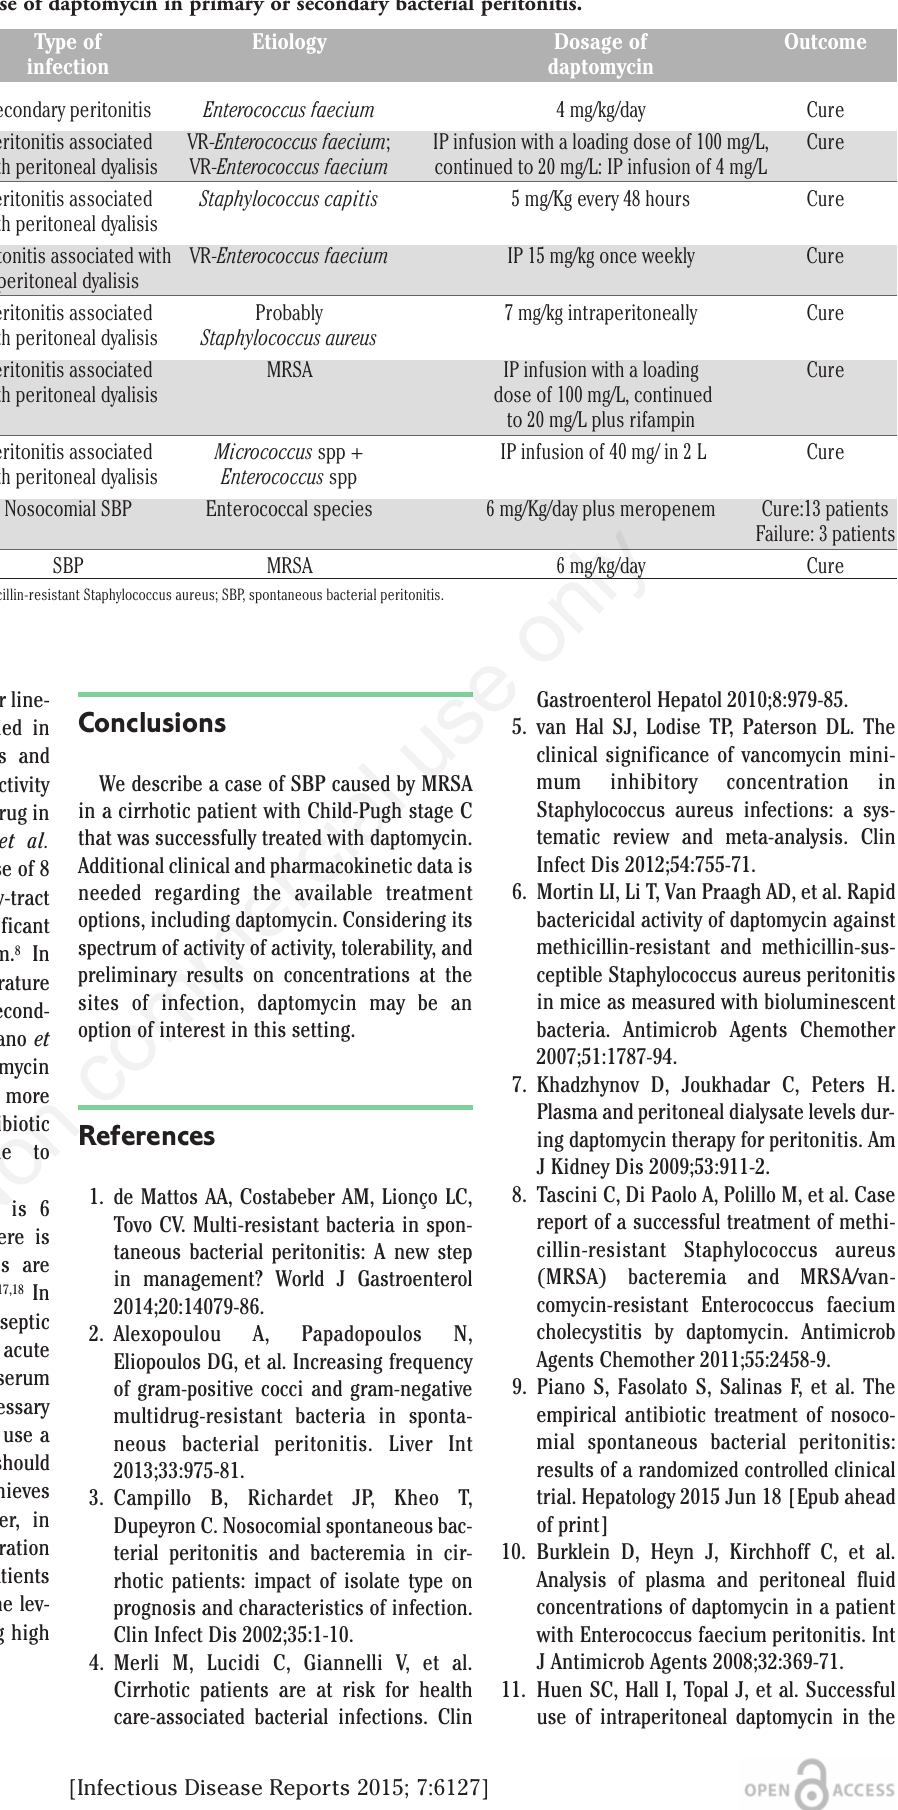
Table 2. Review of literature about use of daptomycin in primary or secondary bacterial